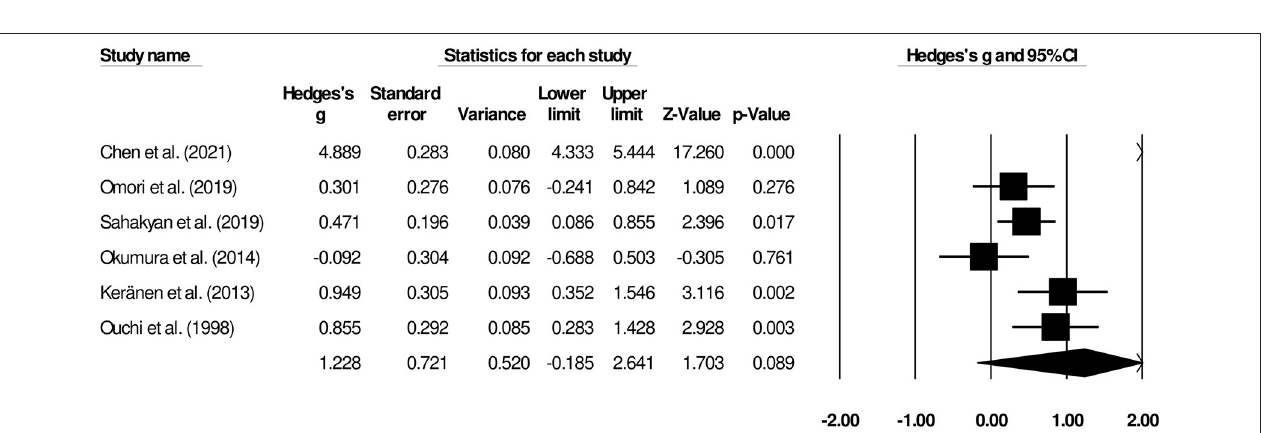
significance in terms of the overall survival duration,